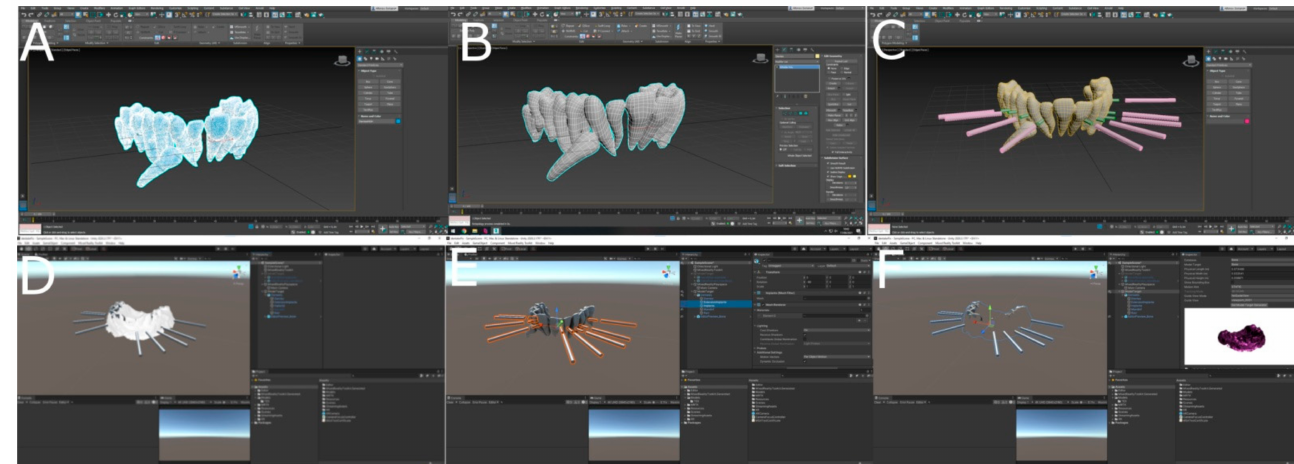
Figure 2. ( A – F ) Planning process in mixed reality device